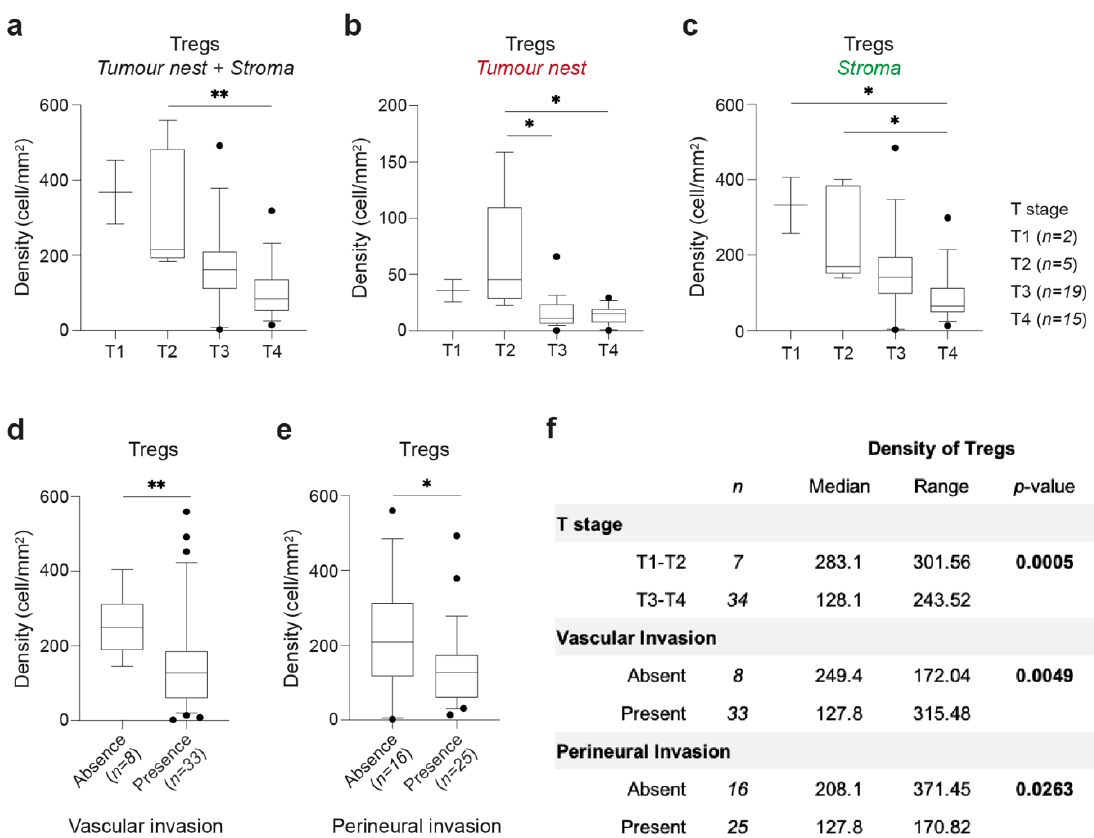
Figure 6. Distribution of Tregs in intestinal-type GCs and association with clinicopathological features. ( a – c ) Density of Tregs at tumor nest and stroma areas ( a ), tumor nest only ( b ), or stroma only ( c ), according to T stage: T1, n = 2; T2, n = 5; T3, n = 19; T4, n = 15. ( d ) Density of Tregs in intestinal-type GC with absence ( n = 8) or presence ( n = 33) of vascular invasion. ( e ) Density of Tregs in intestinal-type GC with absence ( n = 16) or presence ( n = 25) of perineural invasion. ( f ) Summary of the association of Treg density with clinicopathological features of intestinal-type GC. Box and whiskers represent median ± 10–90 percentile. * p < 0.05, ** p < 0.01; Kruskal–Wallis test with Dunn’s multiple comparison test ( a – c ) and Mann–Whitney U test ( d – f ).